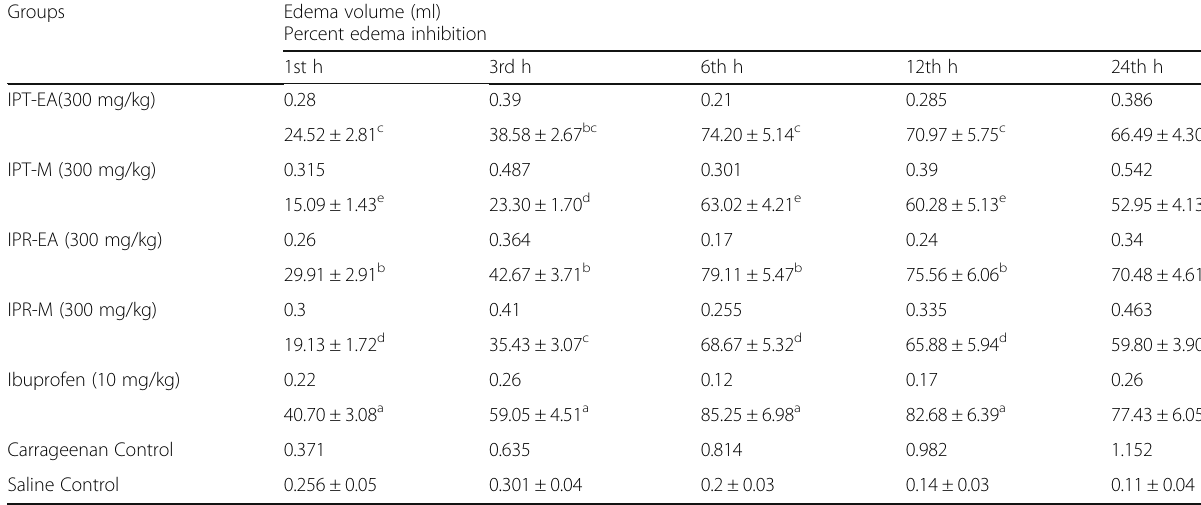
Table 5 Effect of I. batatas on carrageenan-induced paw edema in rat